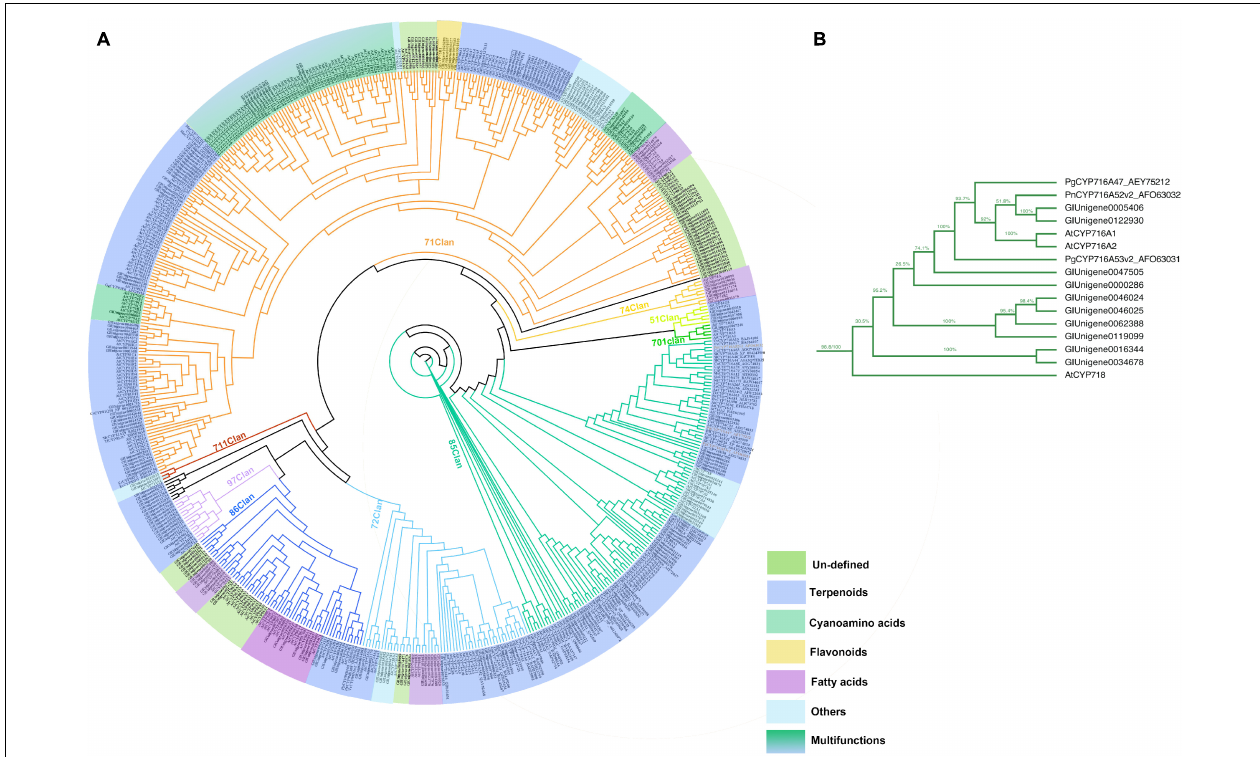
FIGURE 5 | (A) Phylogenetic analyses of the GlCYP s from G. longipes and other reference CYPs, their catalytic functions were classified in colors, blue part related to terpenoids modification, green part related to cyanoamino acid modification, yellow part related to flavonoids modification, light blue part might have other functions, lawngreen part were unidentified. (B) Local zoom of Figure 5A. The phylogenetic analysis of several GlCYP s and